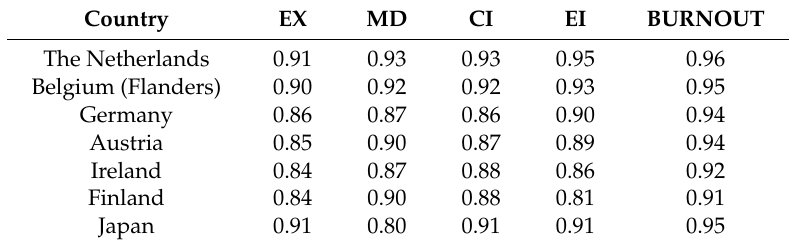
Table 1. Ordinal Cronbach’s reliability coe ffi cients for the burnout assessment tool (BAT). Country EX MD CI EI BURNOUT The Netherlands 0.91 0.93 0.93 0.95 0.96 Belgium (Flanders) 0.90 0.92 0.92 0.93 0.95 Germany 0.86 0.86